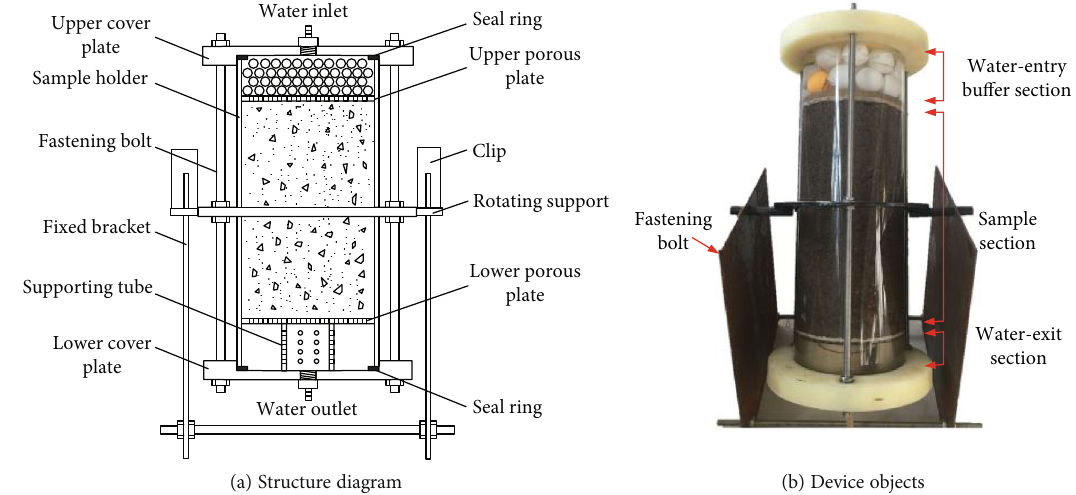
Figure 2: Details of the